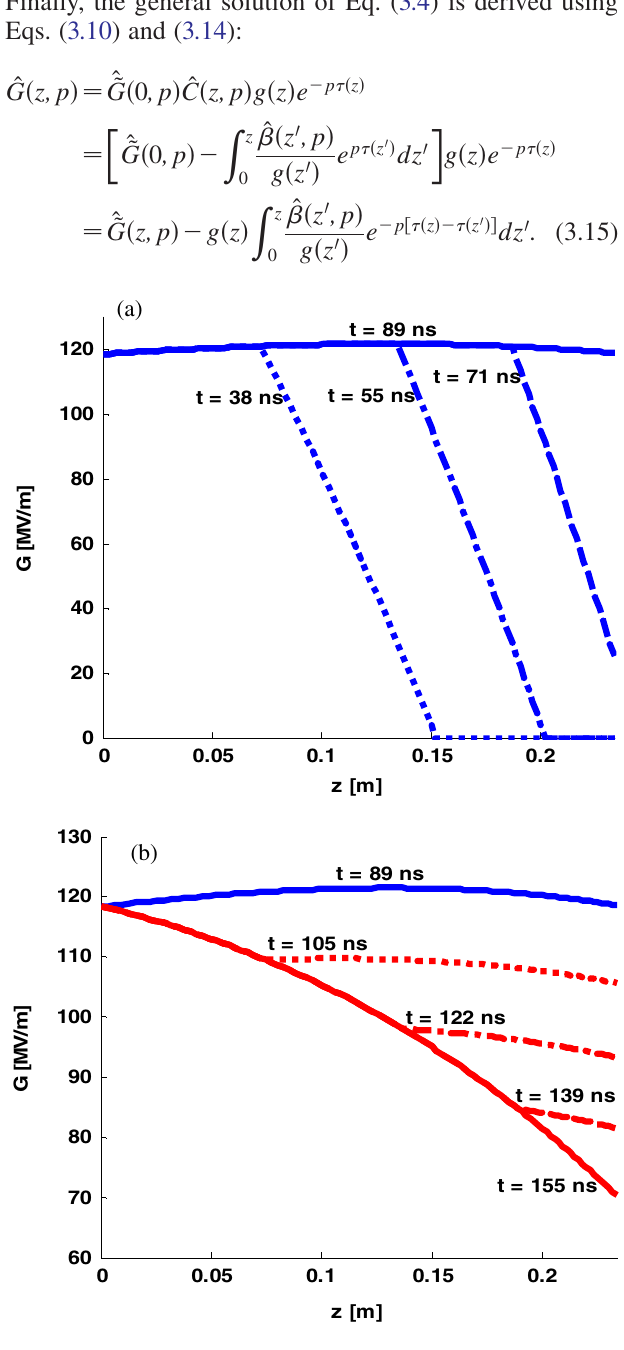
FIG. 4. The instantaneous unloaded (blue) and loaded (red) gradient distributions along the structure at different moments of time during the transient related to structure filling (a) and to the beam injection (b). The steady state solutions are shown as well (solid